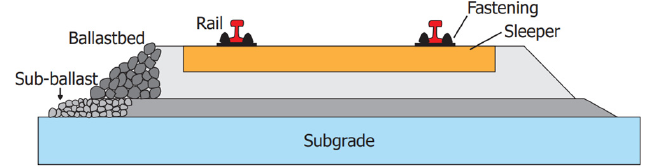
Figure 3. Cross-sectional diagram of the ballasted track.